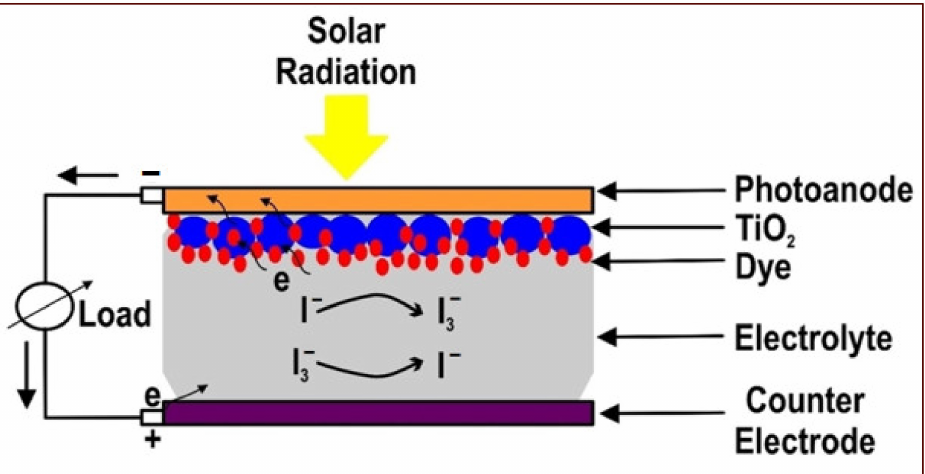
Figure 1. Typical representation of DSSC showing the main components, comprising a photoanode, a semiconducting oxide layer (TiO 2 ), molecular dye, a redox-couple electrolyte, and counter electrode. Electrons exit and make re-entry through the photoanode and counter-electrode systems, respectively. Modified after reference